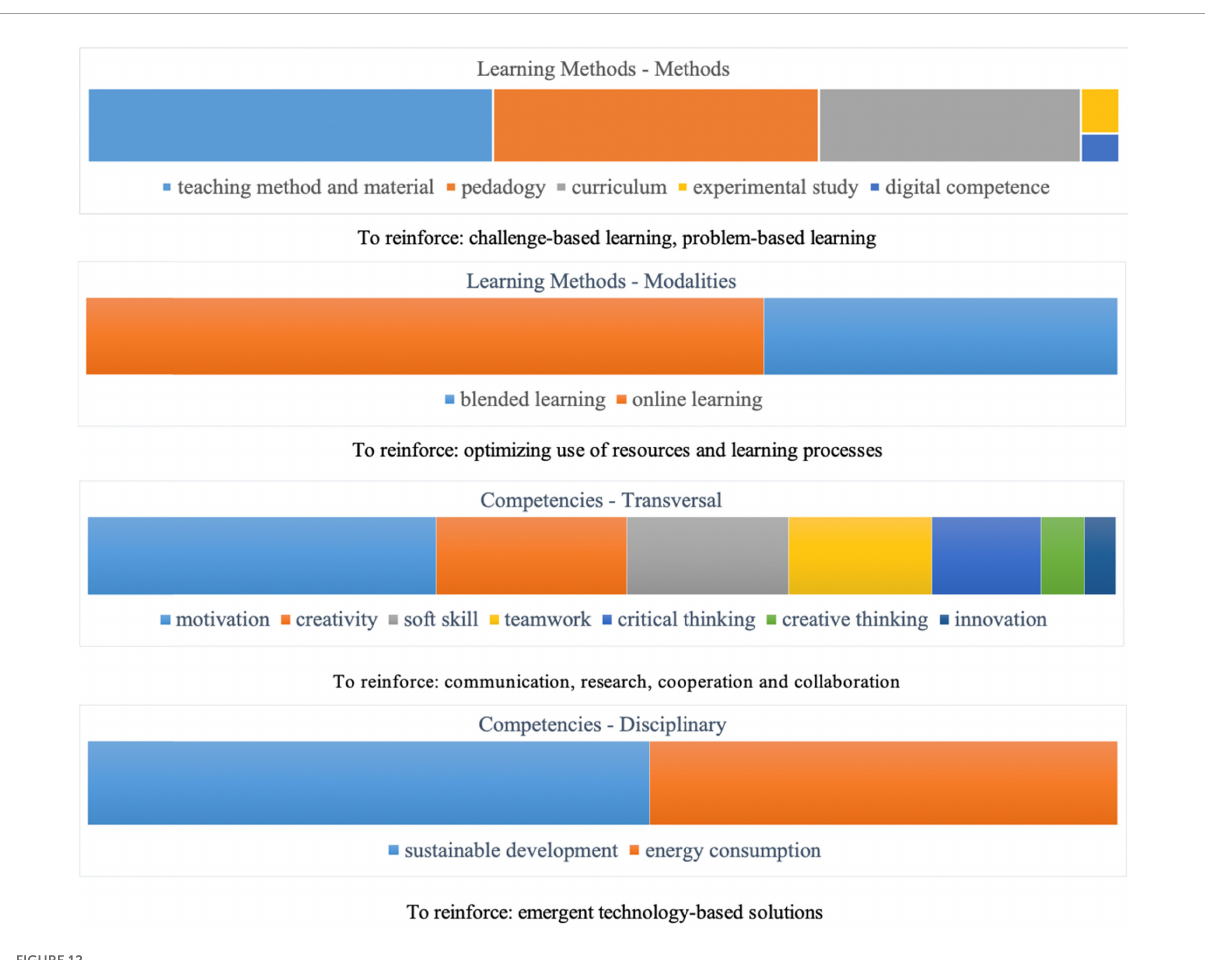
FIGURE12 Recommendations arising from classification and analysis of E.D. 4.0 clusters. Each of these bars represent graphically the relative abundance/deficit of contributory components toward a specific